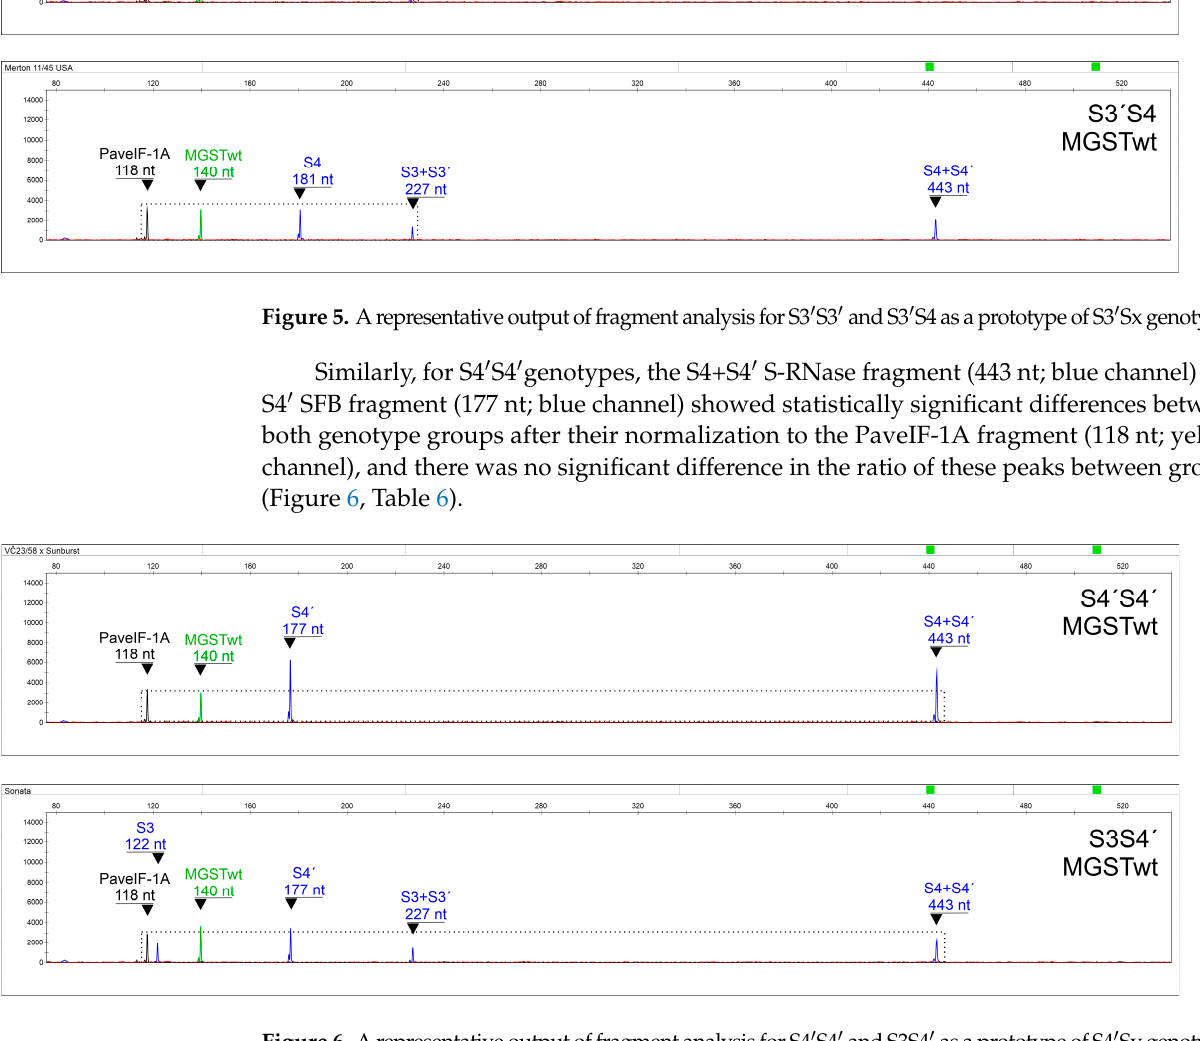
Table 5. A comparison of S3 ′ S3 ′ and S3 ′ Sx genotypes. Ratios of respective peak heights were calcu- lated and compared. MGST with only one allele present was used in parallel to show no signi fi cant di ff erence between the ampli fi cation of the two control genes in both groups. The le tt er in parenthe- ses indicates the channel a speci fi c peak is detected in Y yellow (represented here by black for con- trast); B blue; G green. SD: standard deviation.